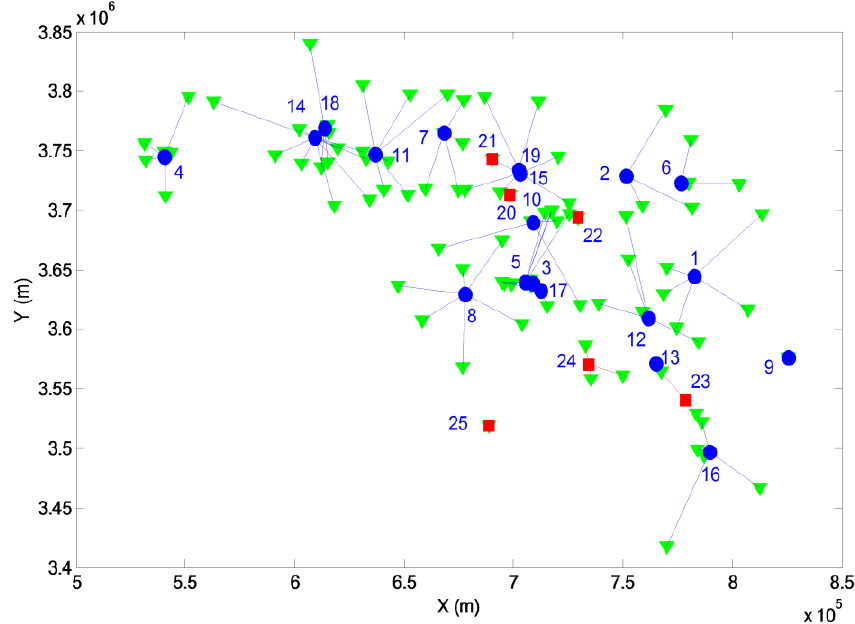
Figure 6. Results of applying BFOA to solve SEP problem on a real network.